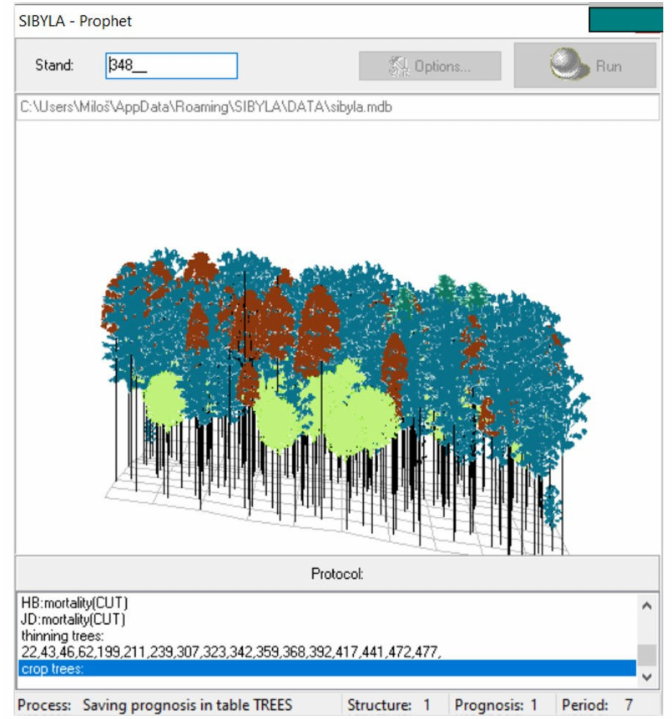
Figure 2. Section of module “Prophet” with running simulation from software SIBYLA